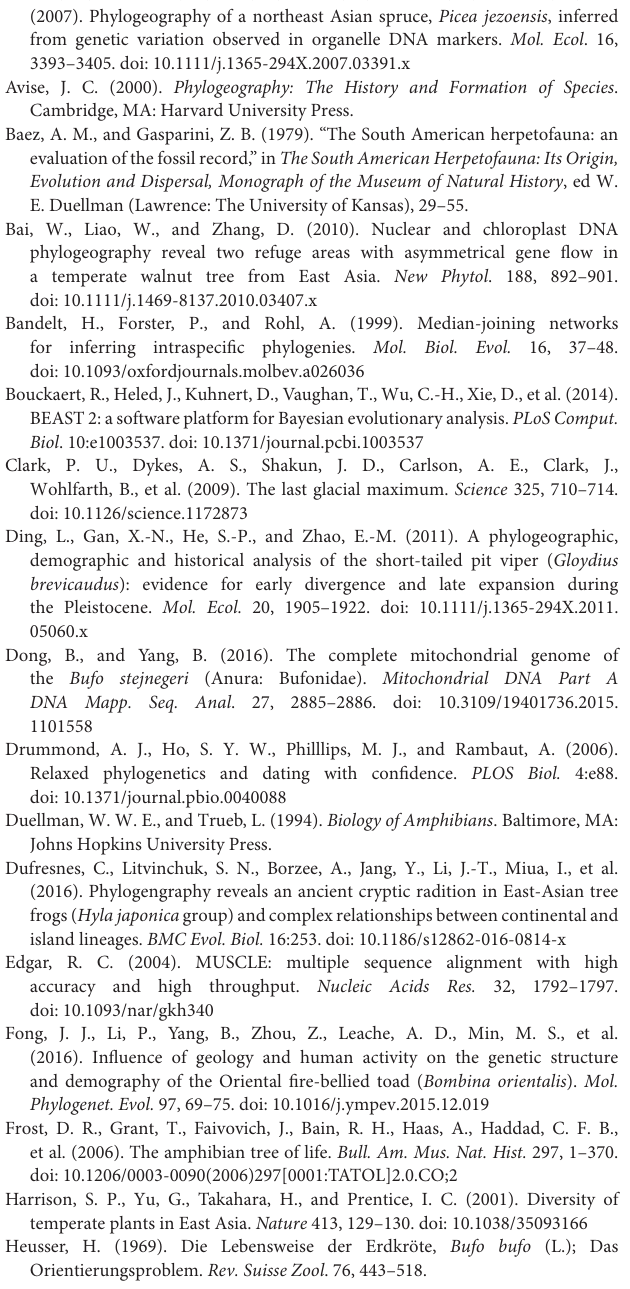
on the map from Figure 1 . Figure S2 | Calculation of phylogenetic informativeness of the 10 markers using PhyDesign. Figure S3 | Phylogeny and divergence dates inferred using BEAST. Numbers at nodes represent the mean divergence date (in Ma [mega-annum]), while bars at